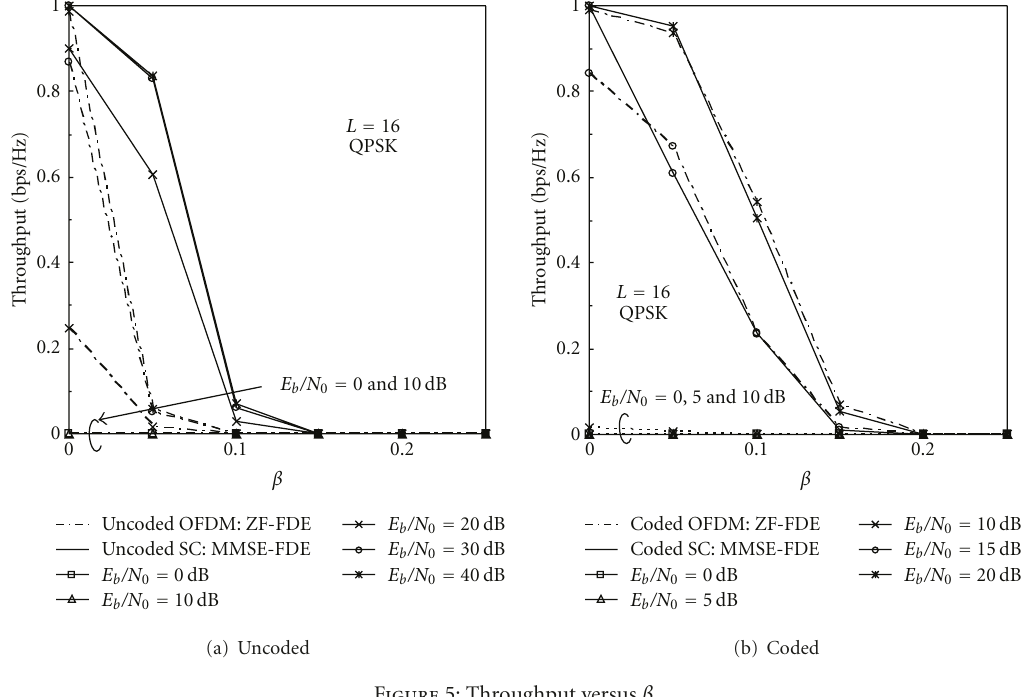
Figure 5: Throughput versus β